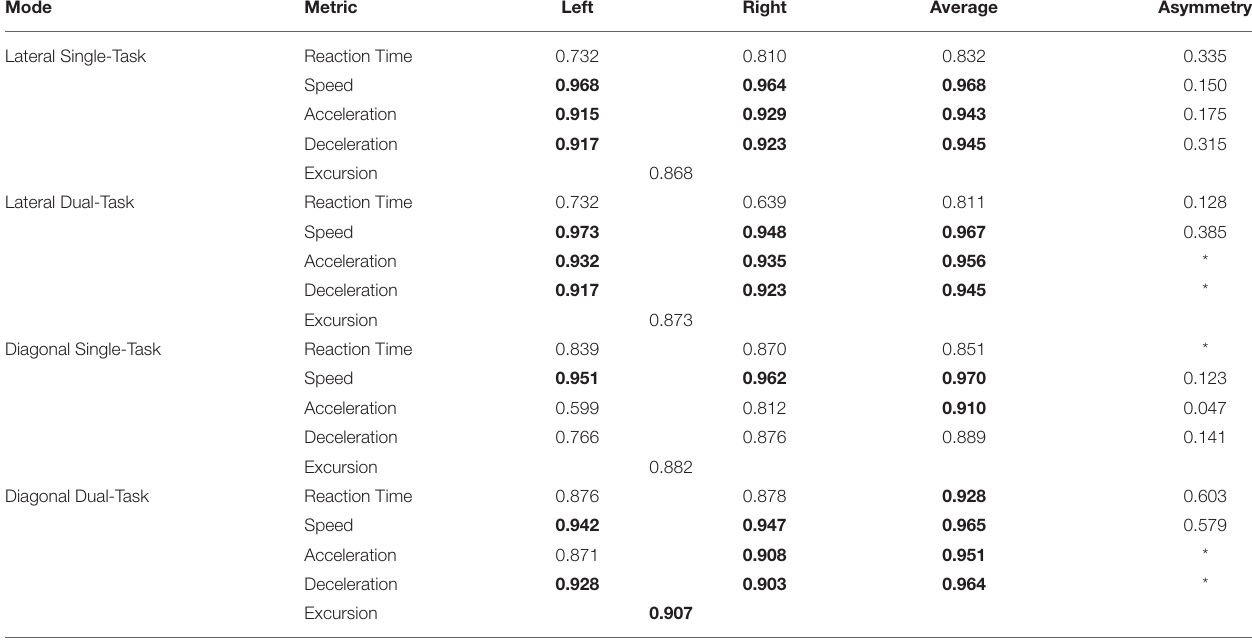
TABLE 2 | Intraclass Correlation Coefficient (3, K) values for consistency of measurements across 12 training sessions.